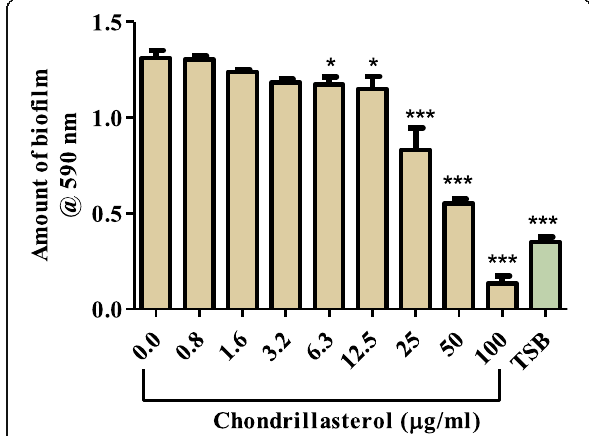
Fig. 6 Effect of chondrillasterol on P. aeruginosa biofilm formation. P. aeruginosa (1.6 × 10 6 cfu/mL) was incubated with different concentrations of the pure compound for 72 h. at 37 °C and the resulting biofilm mass was stained using crystal violet staining. The dye was extracted using ethanol and quantified spectrophotometrically at 590nm. The absorbance values of crystal violet are directly proportional to the amount of biofilm that had formed. The error bars indicate the standard deviation from mean ( n =4). Dunnet multiple